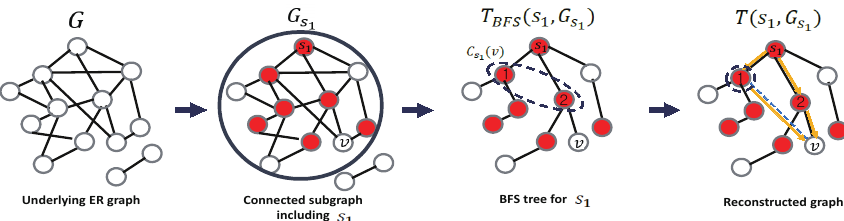
Figure 3. Example of Step 1 (Candidate Infection Path Selection): In the example, the underlying ER random graph G is generated as two disconnected sub-graphs (leftmost). If there is only one cascade source, the cascade occurs only in one connected sub-graph, denoted as G s (second from the left). Based on this, the algorithm first constructs the BFS 1 ) (third from the left). It then selects the set of candidate neighbors C s ( v ) for node v . In this example, tree T BFS ( s 1 , G s 1 1 the distance from the estimated source s 1 to v is d ( s 1 , v ) = 2. Therefore, two nodes (labelled as 1 and 2) are chosen as ) , and node candidate neighbor nodes because their distance from s 1 is 1. Node 2 is already a neighbor in T BFS ( s 1 , G s 1 1 is finally selected as the candidate neighbor and connects an edge to the node v (rightmost). This is referred to as a ) , and the algorithm selects the candidate infection paths including the candidate neighbor reconstructed graph T ( s 1 , G s 1 node (yellow